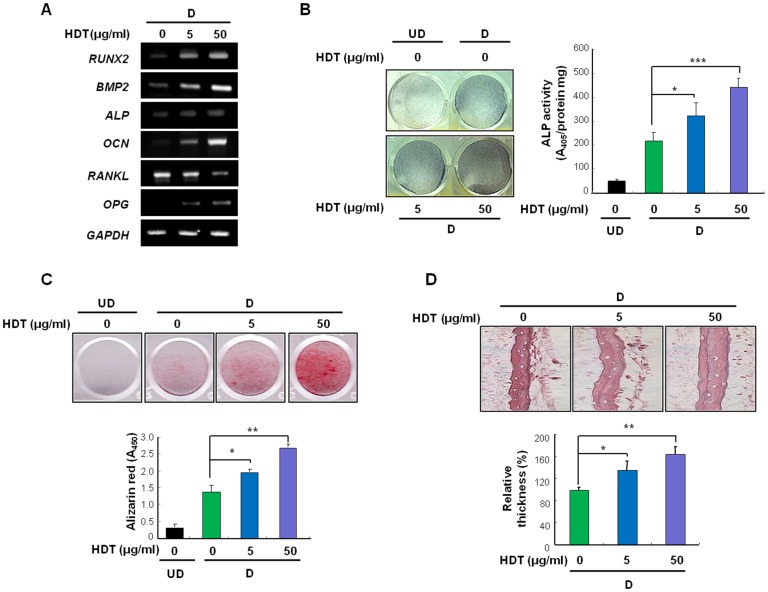
HDT extract has osteogenic effects on calvarial osteoblasts and mouse calvaria.(A–C) Calvarial osteoblast cells were treated with HDT extract or DMSO (control) in osteogenic differentiation (D) or the basic undifferentiation (UD) medium. (A) Calvarial osteoblasts were treated with HDT extract for 3 days followed by harvesting for RT-PCR analyses. (B) Calvarial osteoblasts were treated with HDT extract for 5 days and then subjected to ALP staining (left) or ALP activity measurements (right). (C) Calvarial osteoblasts were treated with HDT extract for 21 days. The cells were then stained with Alizarin Red S solution (up) and quantification was performed by measuring absorbance at 450 nm (n = 3; down). (D) Calvaria were treated with HDT extract in osteogenic differentiation (D) media for 7 days. Thickness of the calvaria was assessed by H&E staining (up) and quantified (down; n = 3). (B–D) *p<0.05, **p<0.01, ***p<0.001 versus control of differentiation medium.